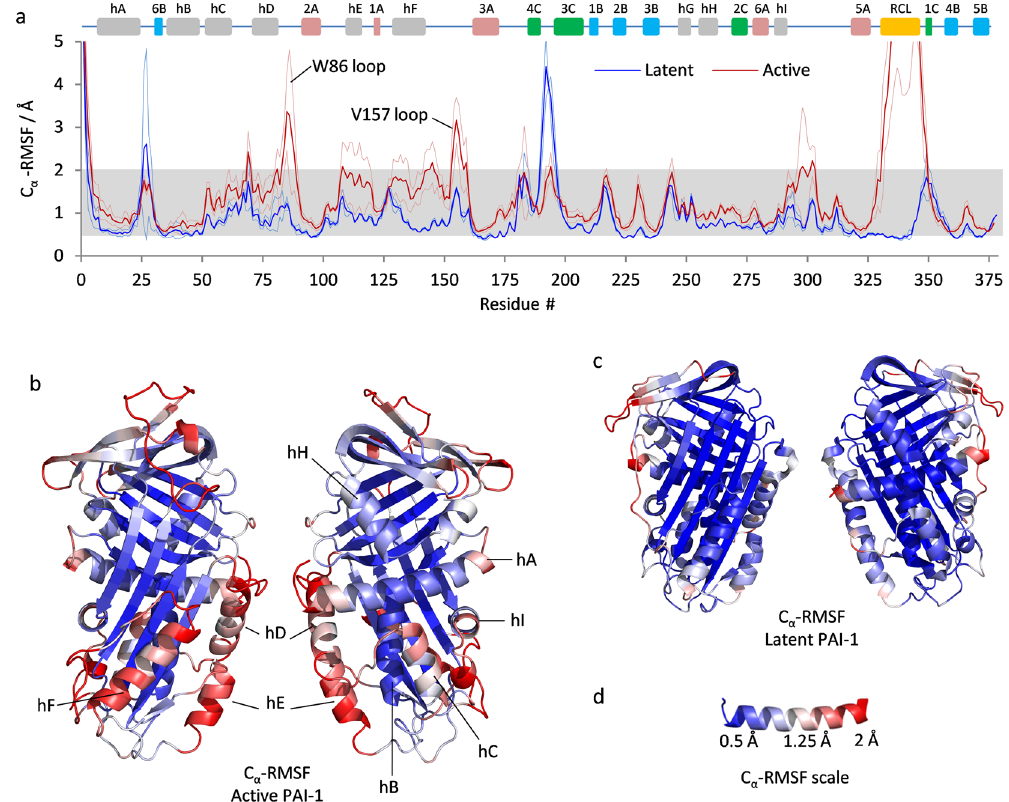
Figure 2. Localized dynamics in active and latent PAI-1. ( a ) The average C α -RMSF values from the four replicate one-microsecond simulations on active PAI-1 and the two one-microsecond simulations on latent PAI-1 are indicated as bright red and blue lines, respectively. The average C α -RMSF values + / − one standard deviation are shown for active and latent PAI-1 as pale red and pale blue lines, respectively. Secondary structural elements are depicted above the plot for reference. The RCL is colored orange, α -helices are colored grey, β -strands from β -sheet A, B and C are colored red, blue and green, respectively. The average C from the simulation on active PAI-1 and the simulation on latent PAI-1 are indicated on the structure of ( b ) active and ( c ) latent PAI-1 according to the color scale shown in ( d ). The range of this color scale is indicated by the grey area in ( a